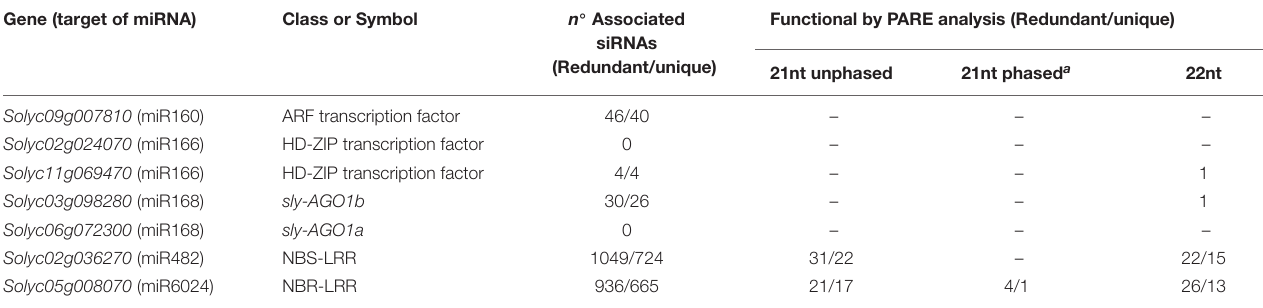
TABLE 2 | Total and phased siRNAs associated with selected targets of miR160, miR168, miR169, miR482, and miR6024 and their functionality by PARE analysis in TYLCS-infected plants. Gene (target of miRNA) Class or Symbol n ◦ Associated